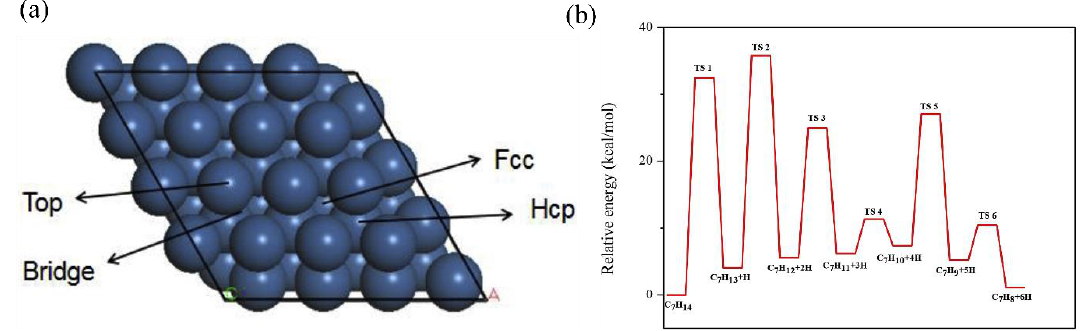
Figure 14. ( a ) Optimized surface structure of Pt(111). ( b ) Complete energy profile for MCH dehydrogenation on Pt(111). Reprinted with permission from [98].